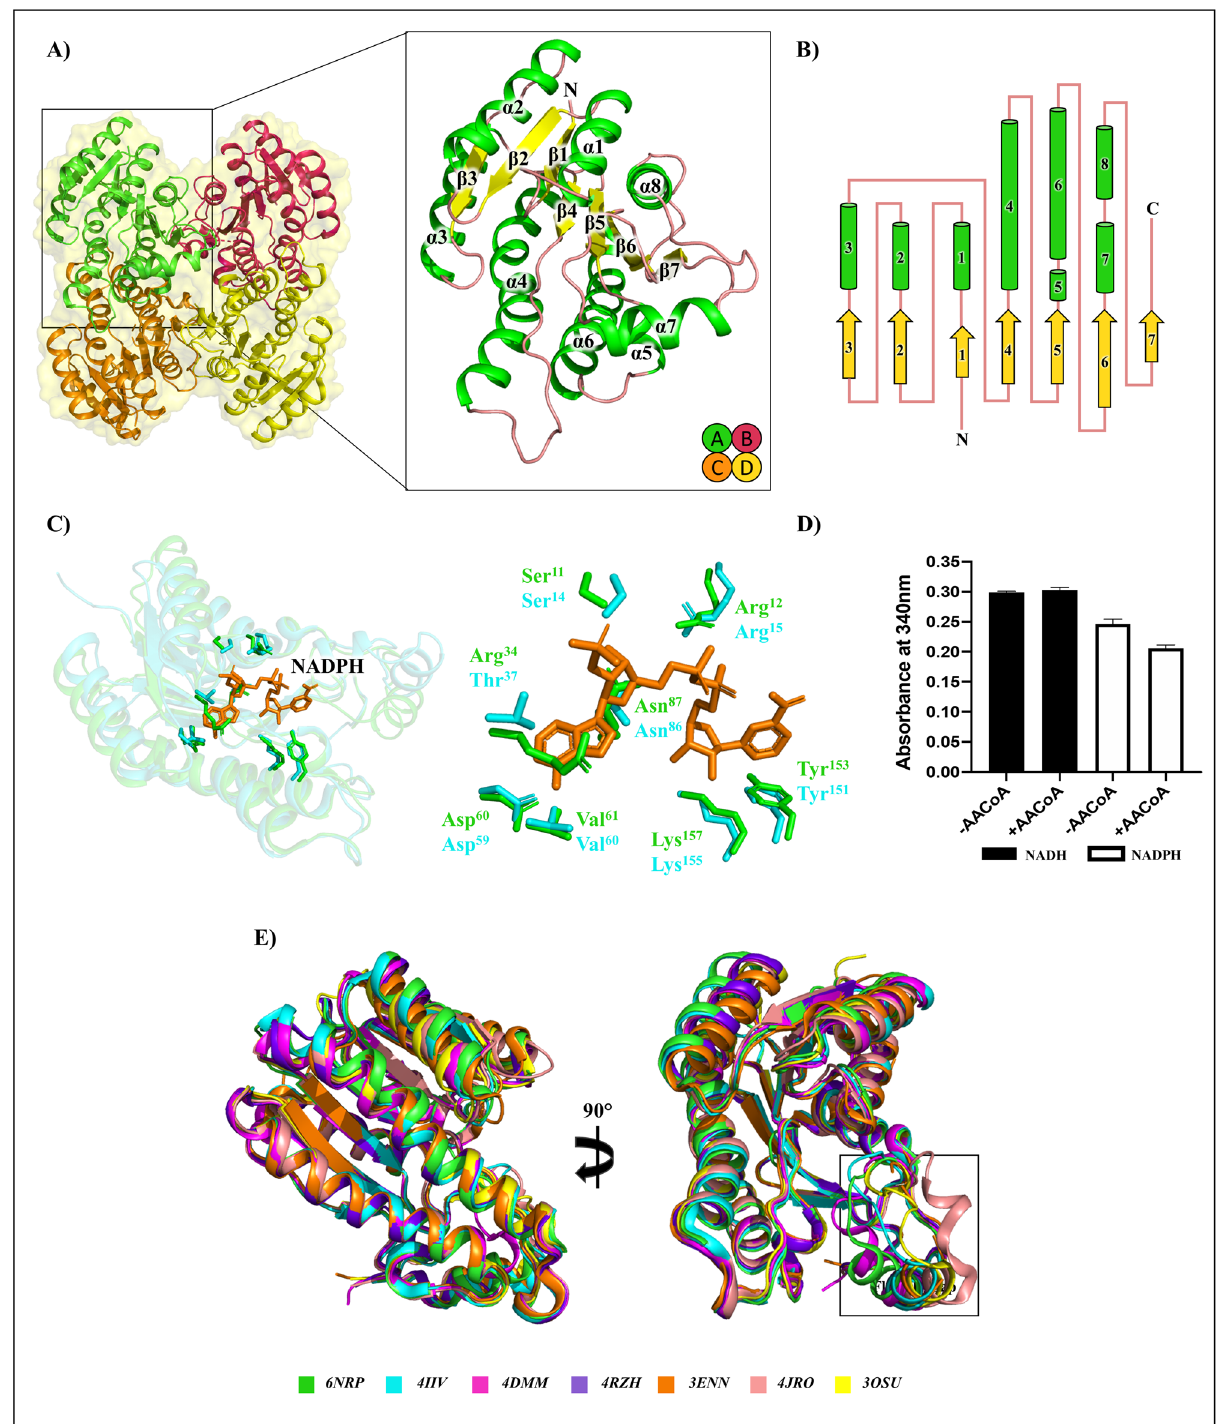
Figure 3. Structure of Ab SDR (ABO10977.2) ( A ) The quaternary assembly and protomer displaying the secondary structure. This model was deposited in the PDB under the code 6NRP. ( B ) Topology diagram of protomer assembly with loops (salmon), α-helices (green), and β-sheets (yellow). ( C ) Superimposition of FabG (cyan) and Ab SDR (green) with NADPH (orange) at the active site. ( D ) FabG enzyme activity assay using acetoacetyl-CoA substrate. ( E ) Superimposition of structurally similar SDR proteins determined through the DALI server. 6NRP short chain dehydrogenase/reductase from A. baumannii (green, this study), 4IIV 3-oxoacyl-ACP reductase E. coli strain CFT073 (cyan, unpublished ), 4DMM 3-oxoacyl-ACP reductase from Synechococcus elongatus PCC 7942 in complex with NADP (magenta, unpublished ), 4RZH 3-oxoacyl-ACP reductase from Synechocystis sp. PCC 6803 (purple, Liu et al. 43 ), 3ENN glucose/ribitol dehydrogenase from Brucella melitensis (orange, unpublished ), 4JRO 3-oxoacyl-ACP reductase Listeria monocytogenes in complex with NADP + (salmon, unpublished ), 3OSU 3-oxoacyl-ACP reductase from Staphylococcus aureus (yellow, unpublished ). The black box indicates the SDR flexible capping region. All figure images were generated/drawn by the